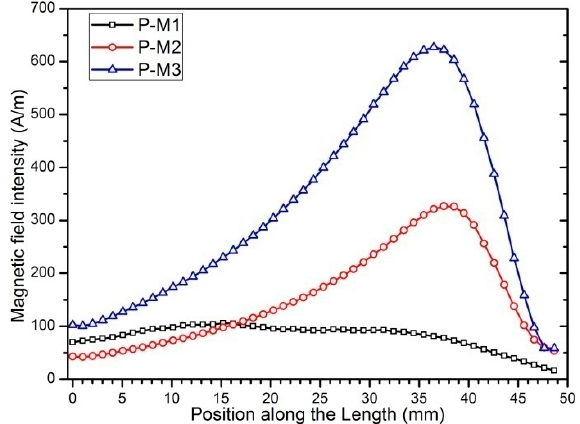
Figure 17. Comparison of the average magnetic field intensity along the length direction of the Fe-Ga layer with different pre-magnetized layouts.